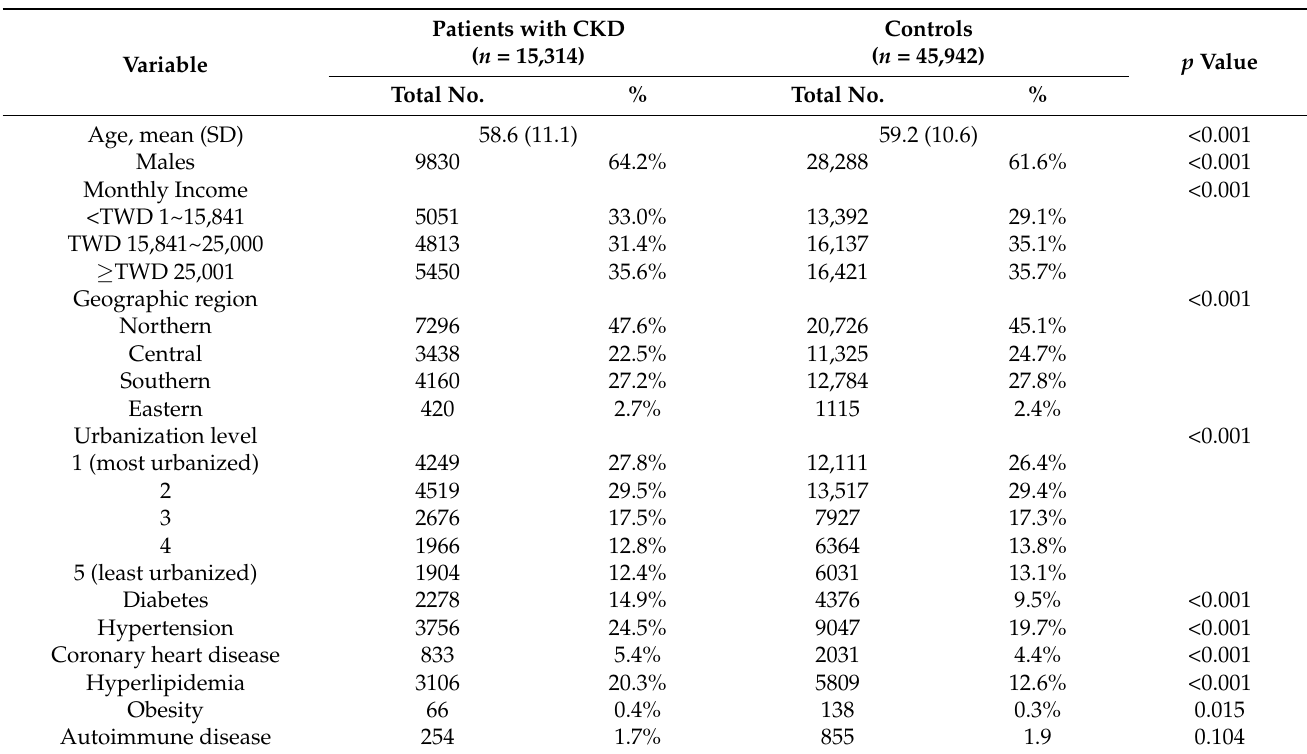
Table 1. Demographic characteristics of chronic kidney disease (CKD) cases and controls in Taiwan ( n = 61,256).